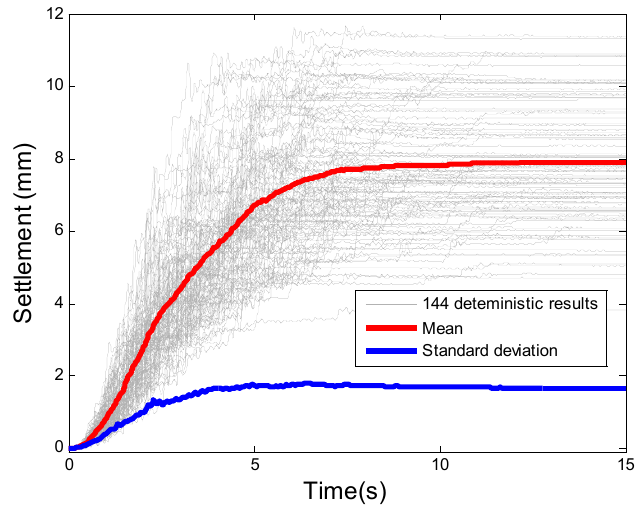
Figure 12. Mean value, standard deviation, and 144 deterministic results of the seismic settlement at the pile head under stochastic ground motions.